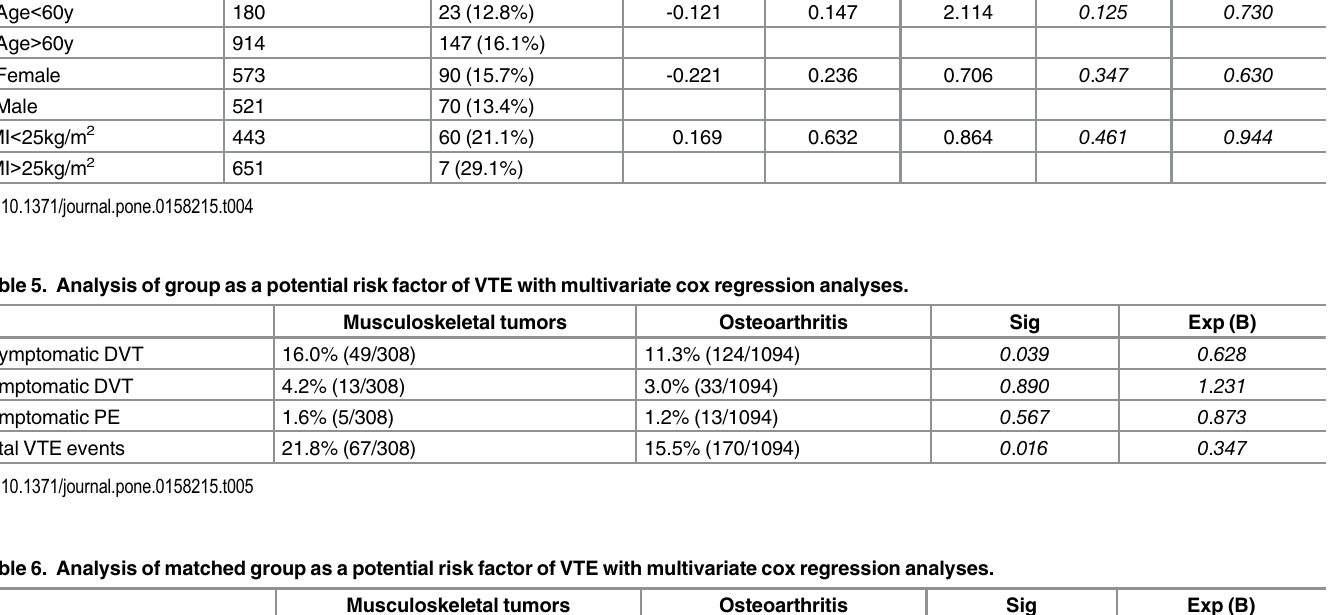
Table 4. Potential risk factors of VTE for patients with osteoarthritis with multivariate cox regression analyses. Demographic data